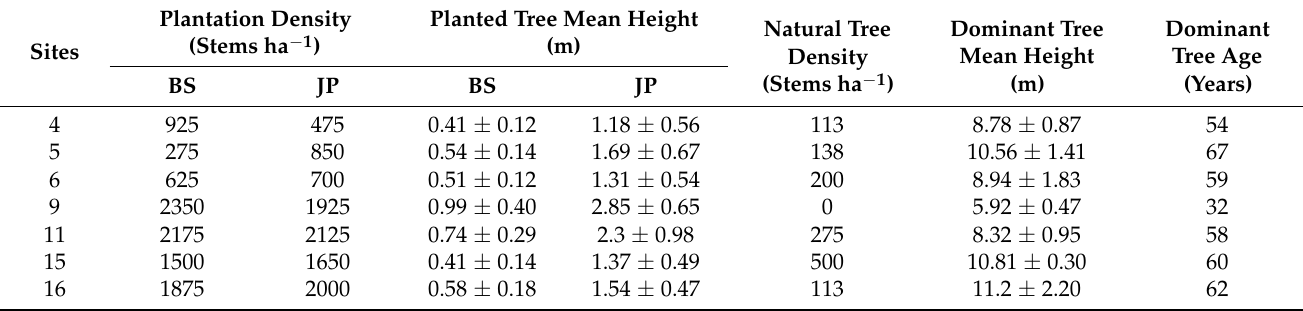
Table 1. Characteristics of the sampled afforested open woodlands (OW), planted with black spruce (BS) and jack pine (JP) trees. For natural (i.e., not planted) trees, only with DBH over 9 cm were included. All values represent mean ( ± SE).